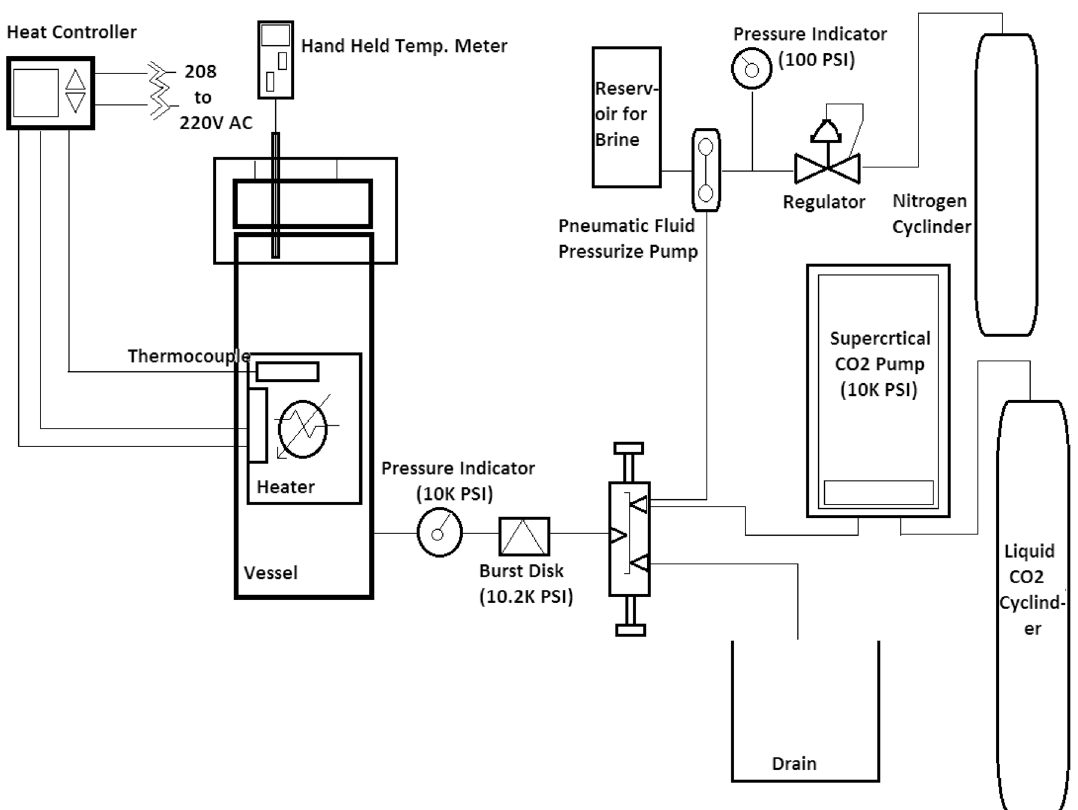
Fig. 2 Schematic view of the static reactor designed and installed at Curtin University